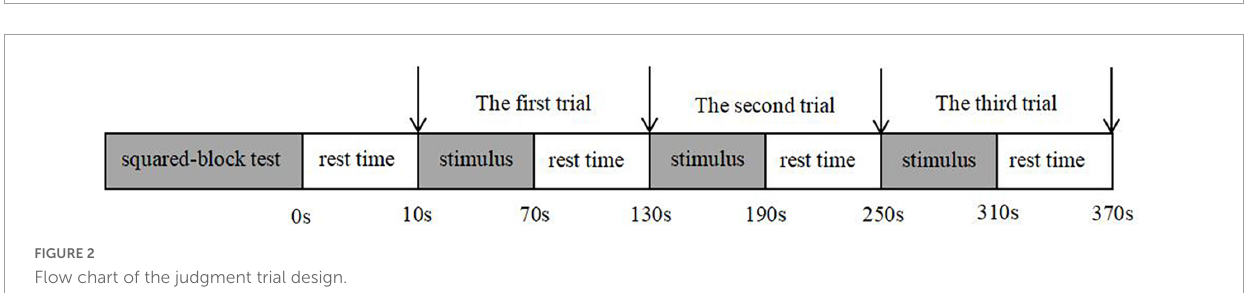
FIGURE2 Flow chart of the judgment trial